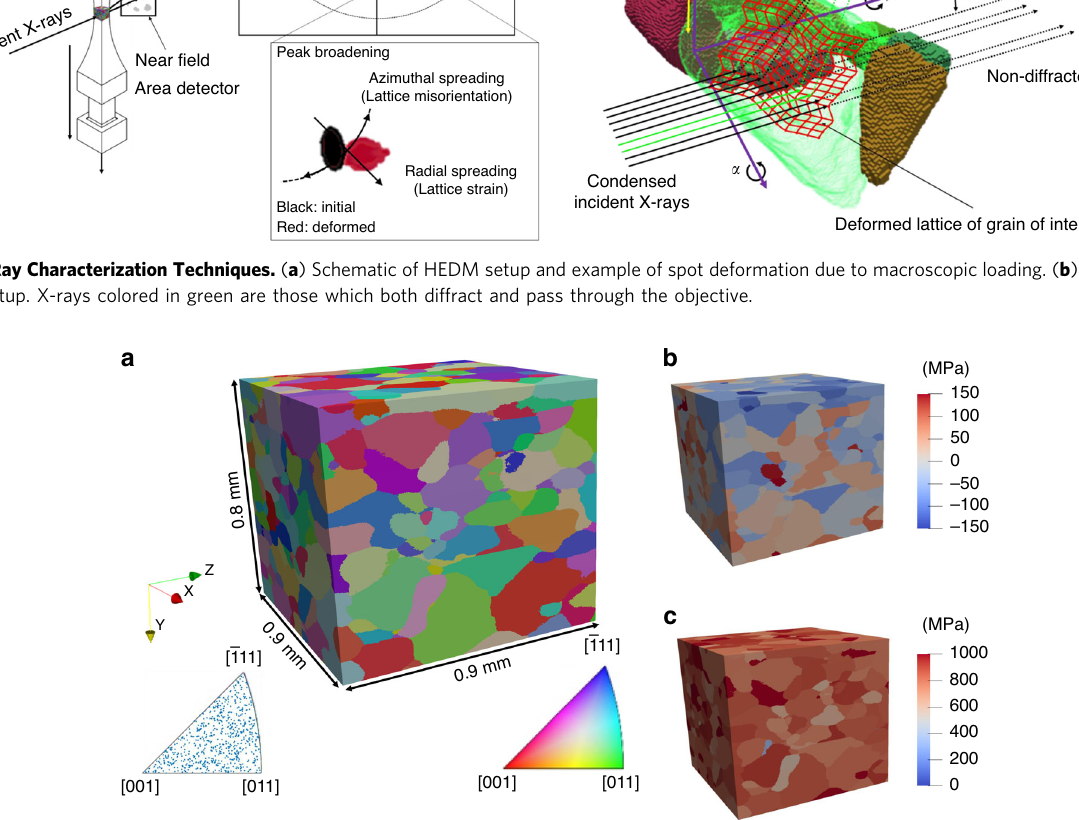
Fig. 2 HEDM Characterization. ( a ) Near- fi eld HEDM reconstruction of sample gauge section, colored and described by inverse pole fi gure (IPF). ( b ) Sample reconstruction colored with grain averaged stresses in the loading direction (y-axis as labeled) when unloaded, prior to loading. ( c ) Sample reconstruction colored with grain averaged stresses in the loading direction when loaded to 1% macroscopic strain, after